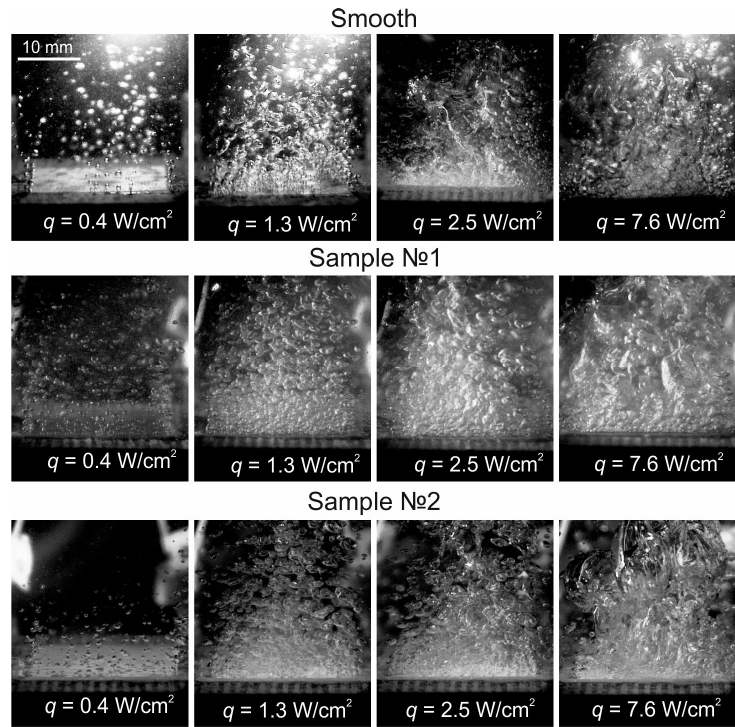
Figure 7. Boiling process at 0.05 MPa.